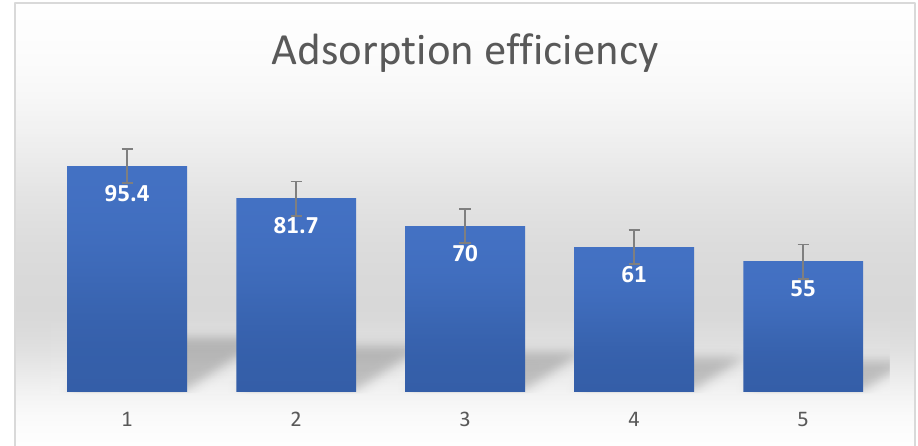
Figure 14. Repeatability of the Pb 2+ adsorbent made from polypyrrole ‐ polyethyleneimine.